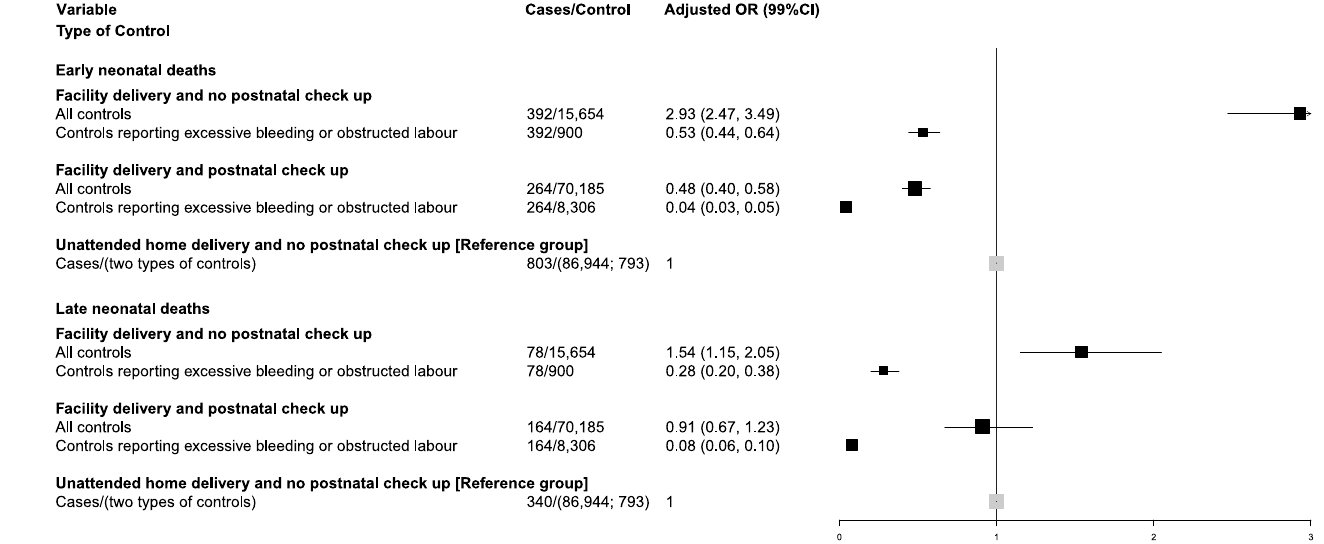
Fig 2. Adjusted odds ratios for early neonatal deaths and late neonatal deaths for facility deliveries by different controls, India 2004 – 08.